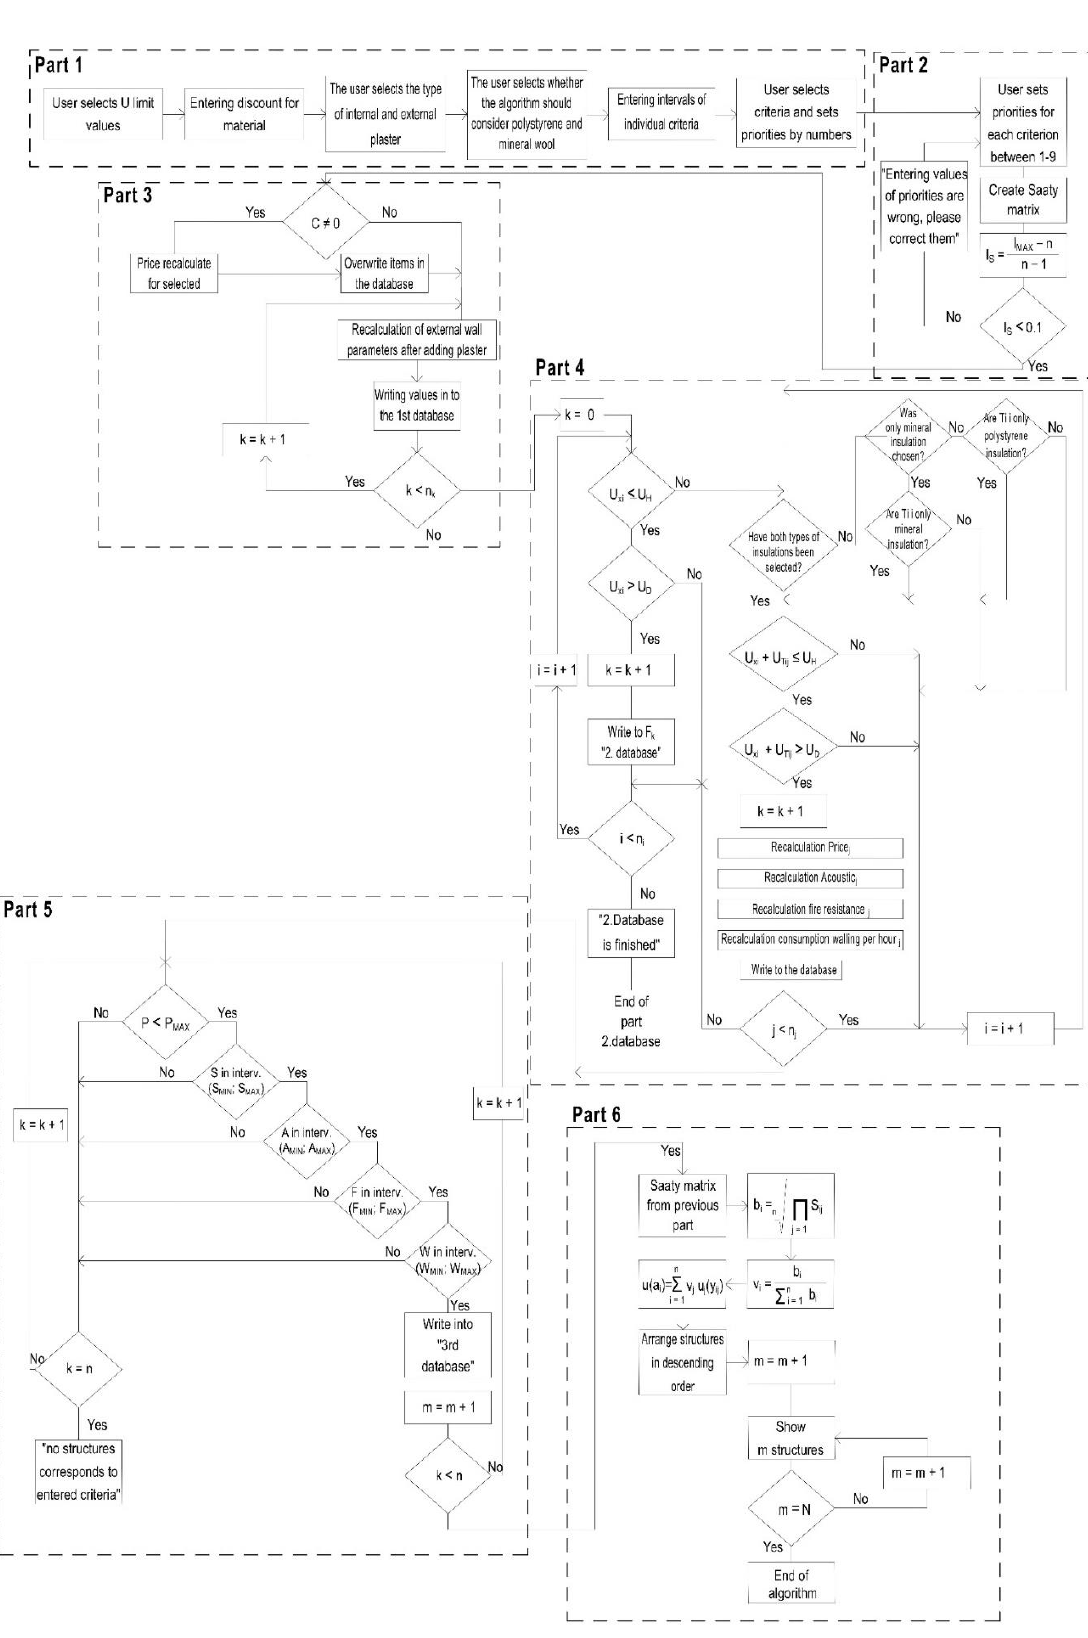
Figure 5. The whole process of the second method of searching for structures by the priority of each criterion.